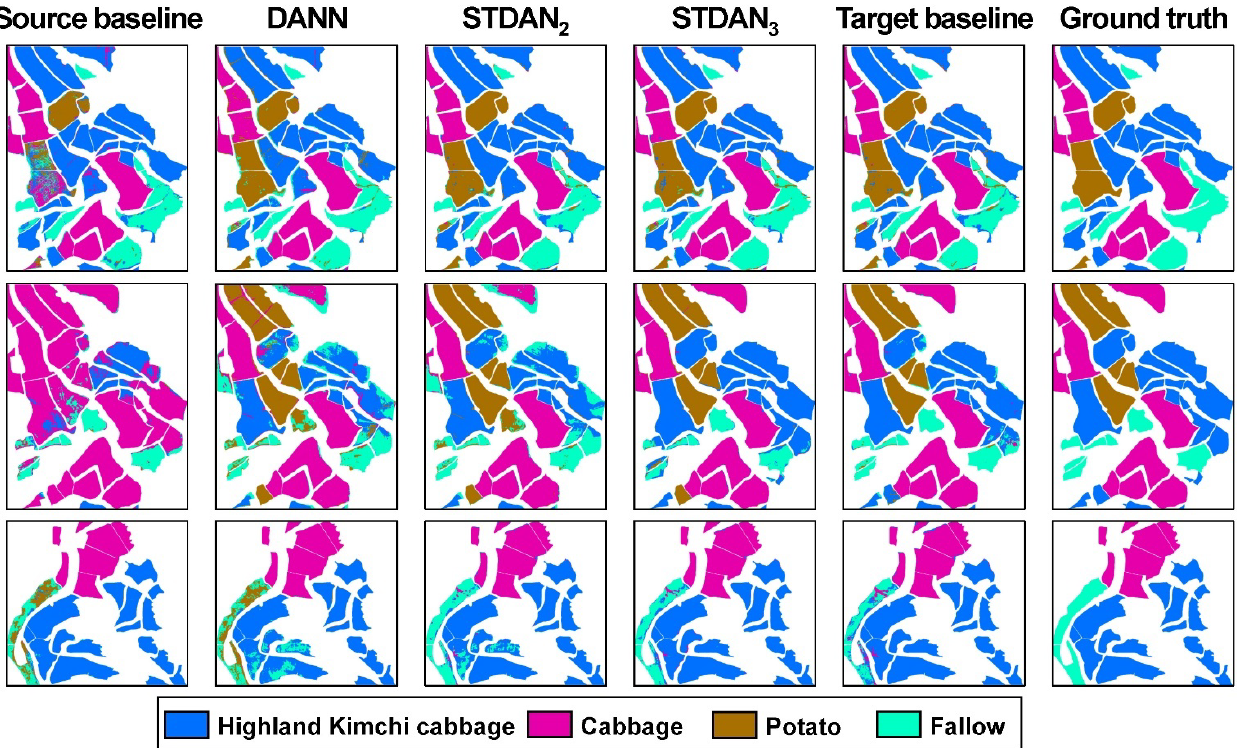
Figure 11. The five classification results for cases 4, 5, and 6 as well as the ground truth data in Gyeongsang. Despite the improved performance of DANN, its misclassification was more substan- tial than the source baseline for case 3, where the target image with different sowing times